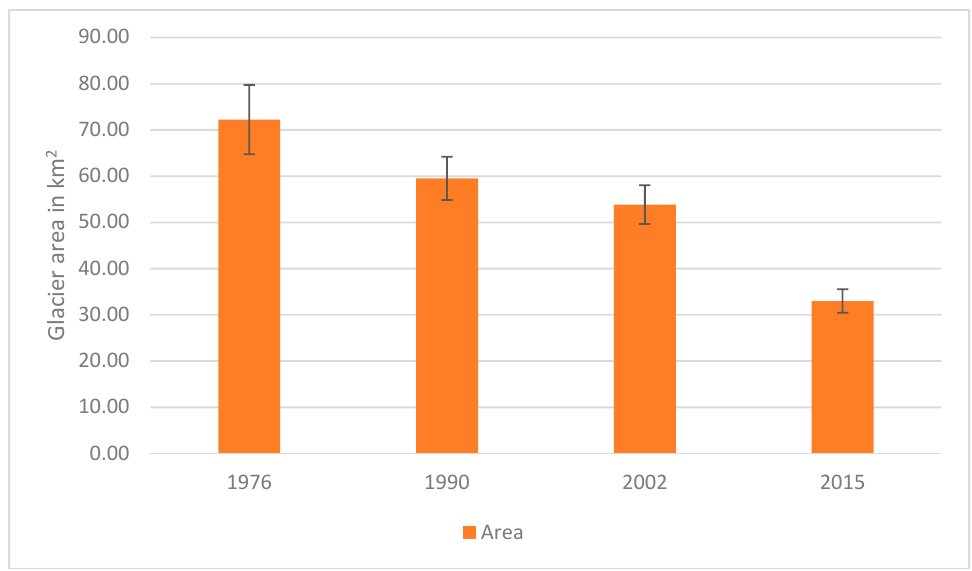
Figure 3. Total glacier area changes in km 2 for the four time steps 1976, 1990, 2002, and 2015 with standard deviation. Table 5. Total glacier areas and changes and for the four sub-regions in the years 1976, 1990, 2002, and 2015 including standard